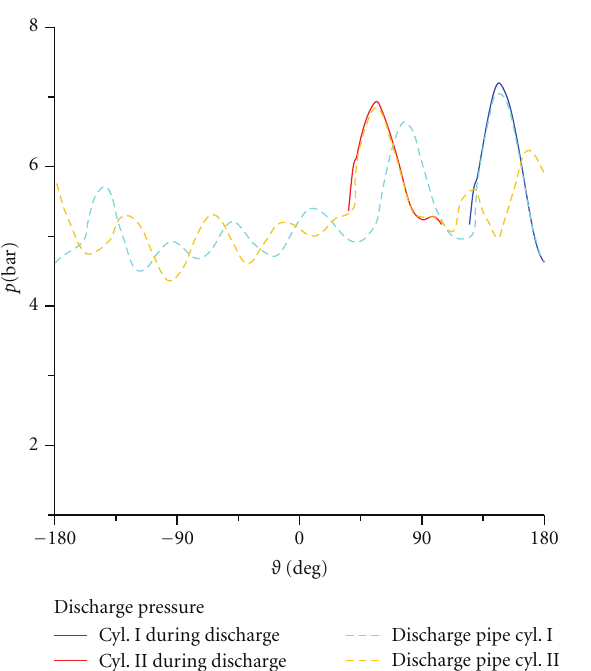
Figure 7: Pressure in the discharge pipes at β = 5.